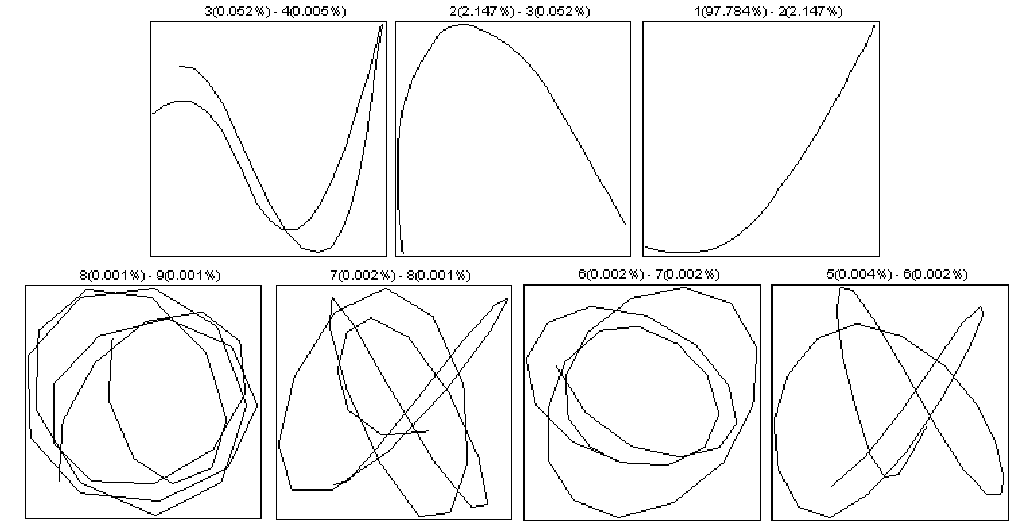
Figure 10. Scatterplots corresponding to the first nine paired principal components.